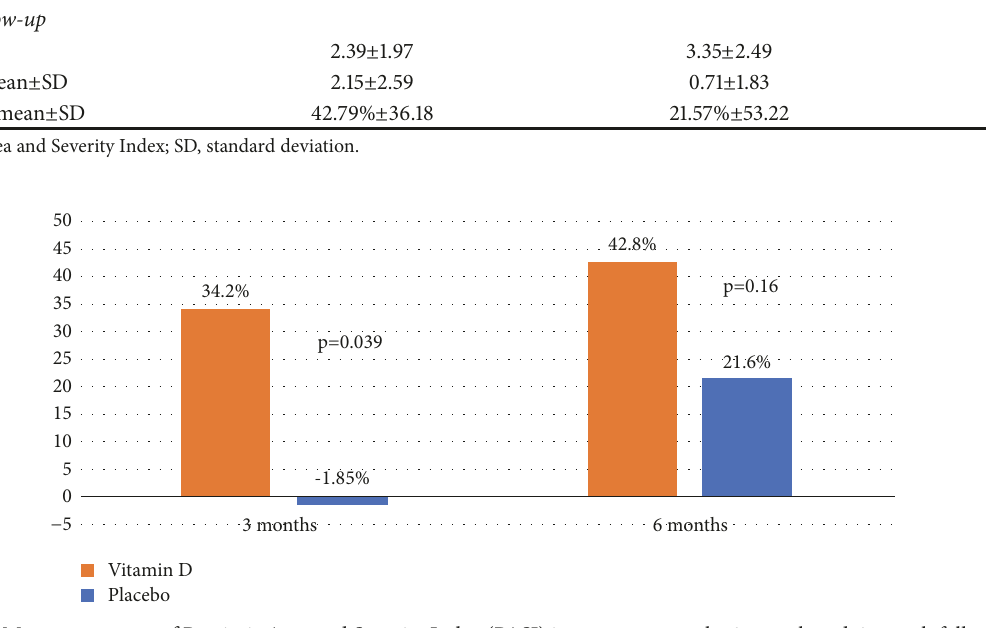
Figure 2: Mean percentage of Psoriasis Area and Severity Index (PASI) improvement at the 3-month and 6-month follow-ups.